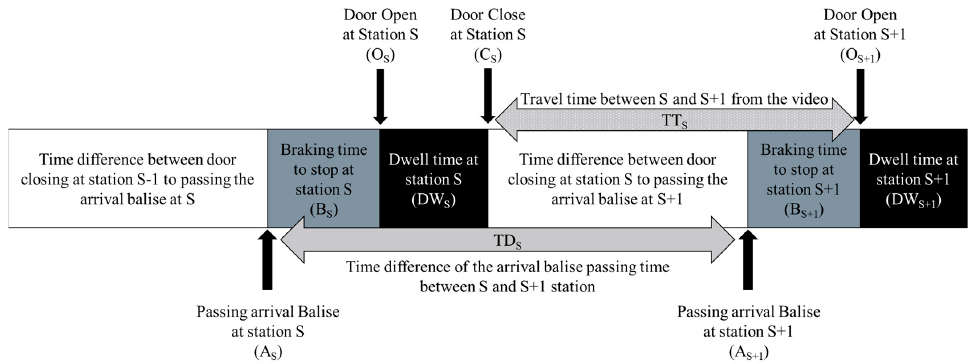
Figure 5. Time components of railway operation between stations and definitions of TT S and TD S.